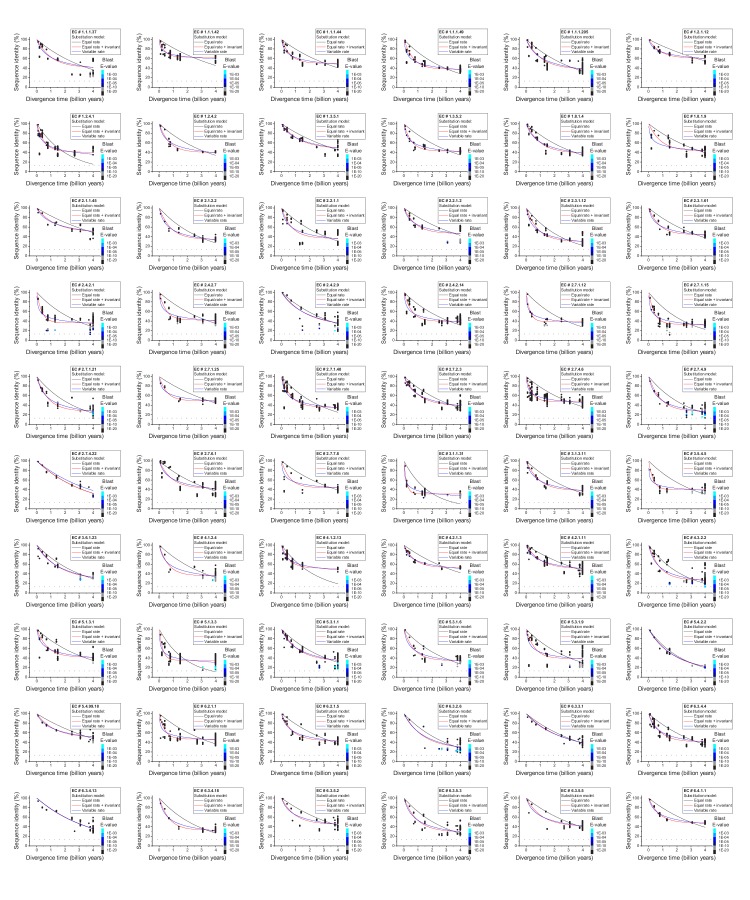
Sequence divergence of enzyme orthologs as a function of time.The global pairwise sequence identities between pairs of orthologous enzymes as a function of divergence times between the corresponding species. The colored lines indicate fits to the data using the three models of amino acid substitutions (Equations 1-3). The horizontal dashed black lines show the average sequence identity for the global alignment of unrelated protein sequences. Dot colors indicate the corresponding psi-blast E-value of the pairwise alignments for a database size of 3.8 × 105 sequences. Parameter fits of the divergence models are presented in Supplementary file 2a.10.7554/eLife.39705.004Figure 1—figure supplement 1—source data 1.Sequence identity versus divergence times for 64 enzyme families.